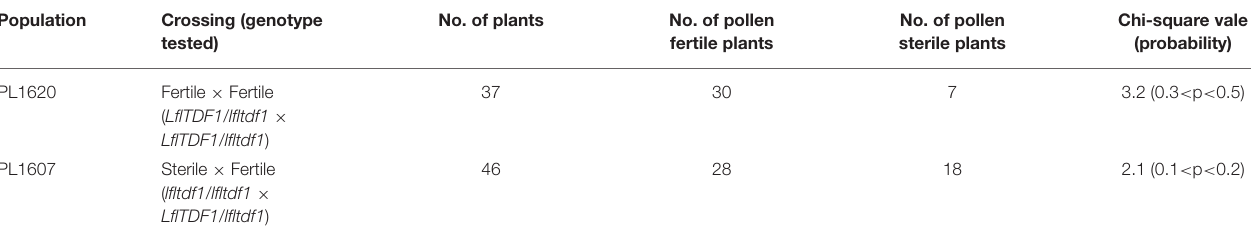
TABLE 1 | Chi-square test for segregation of pollen-fertile and sterile plants in the segregating populations. Population Crossing (genotype